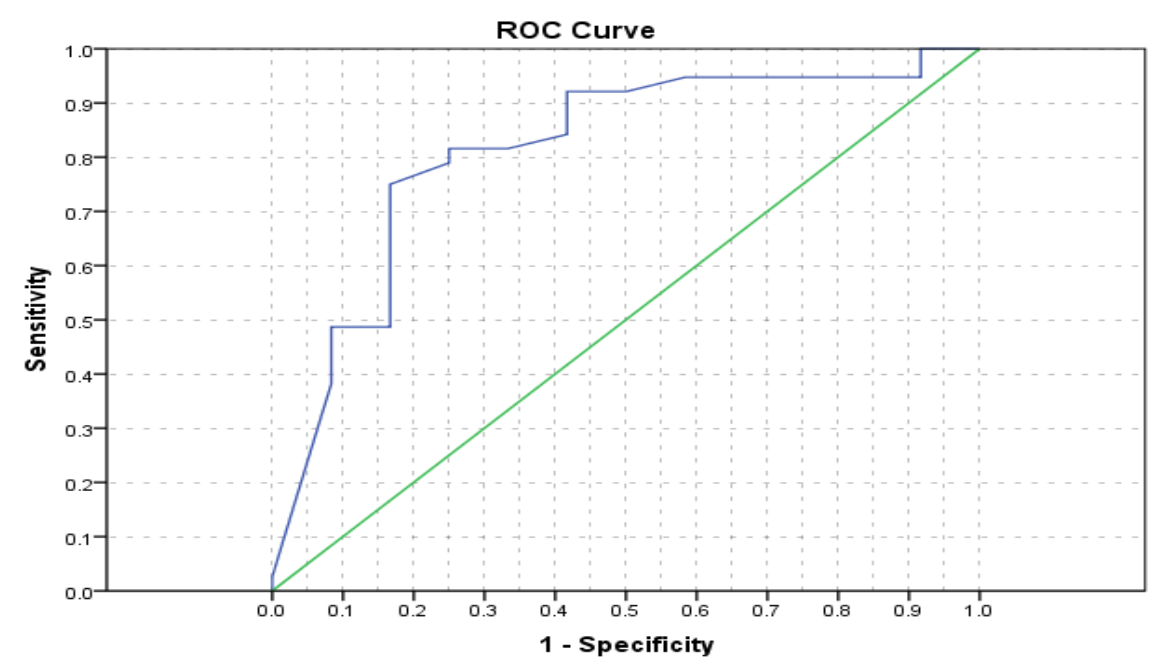
Figure (3)Receiver operating characteristic ROC: Receiver operating characteristic used to find cut off value of mean SBPR of highest and sensitivity and specificity Discussion: Mean age of patients is 55.49±7